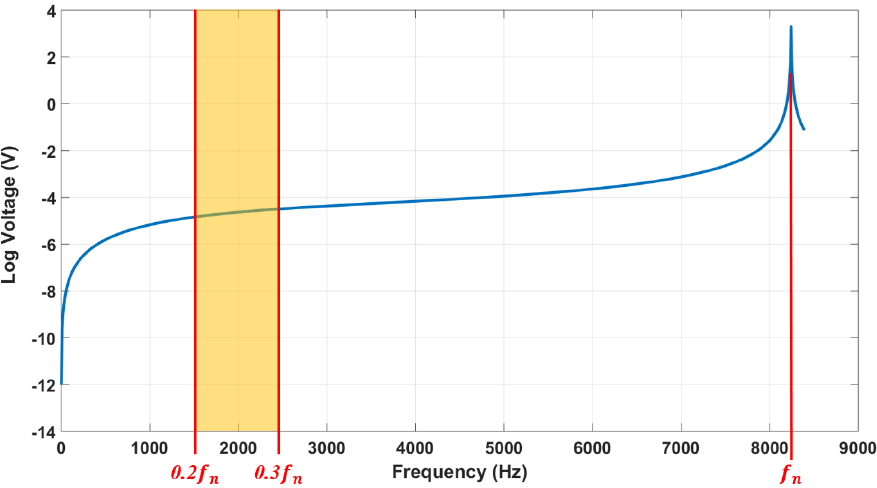
Figure 7. The Log voltage against frequency for the CPS.